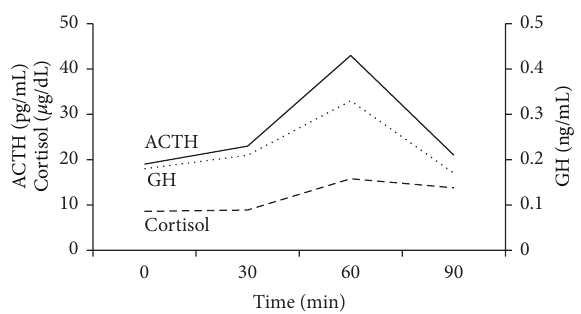
Figure 2: Insulin tolerance test. Regular insulin (0.1U/Kg) was intravenously administered as a bolus with a nadir plasma glucose level (28 mg/dL) at 30